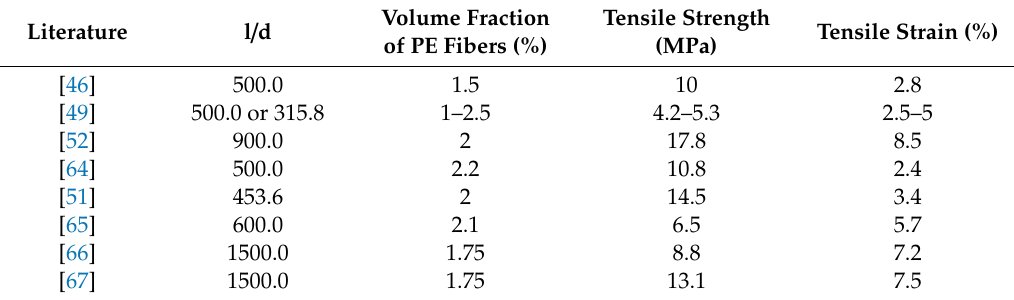
Table 2. The tensile properties of cementitious composites with PE